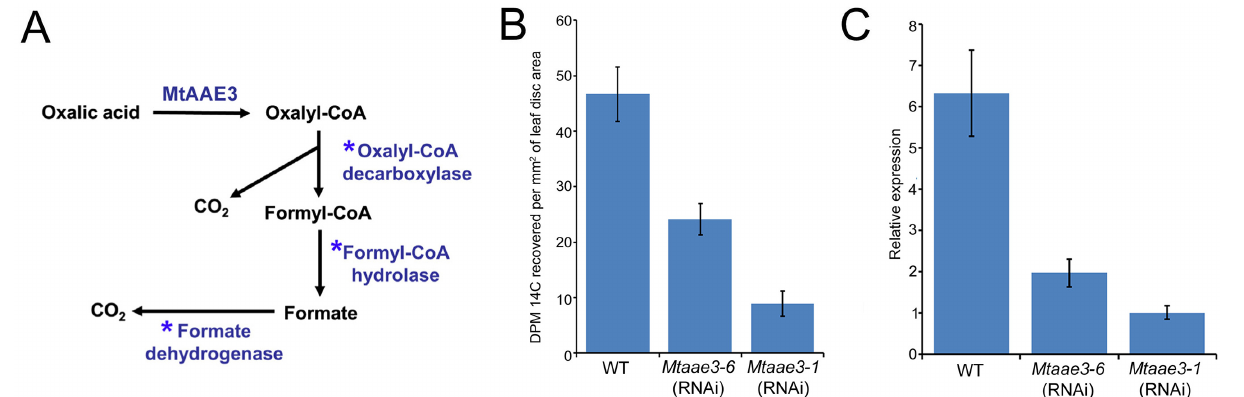
Fig 2. Measurement of oxalate degradation to CO 2 . (A) Schematic of the proposed pathway of oxalate catabolism in M . truncatula . Asterisks denote enzymatic steps remaining to be validated. (B) Radiolabeled CO 2 measurements. WT and Mtaae3 knock-down leaf pieces were fed with 2.5 μ Ci of [ 14 C]- oxalate along with 300 μ M non-labeled oxalate. The 14 CO 2 evolved was captured using 1M KOH and the relative radioactivity was measured. (C) Relative MtAAE3 transcript levels in leaves of Mtaae3 knock-down lines compared to WT as measured by qRT-PCR. Ubiquitin was used as the reference gene.